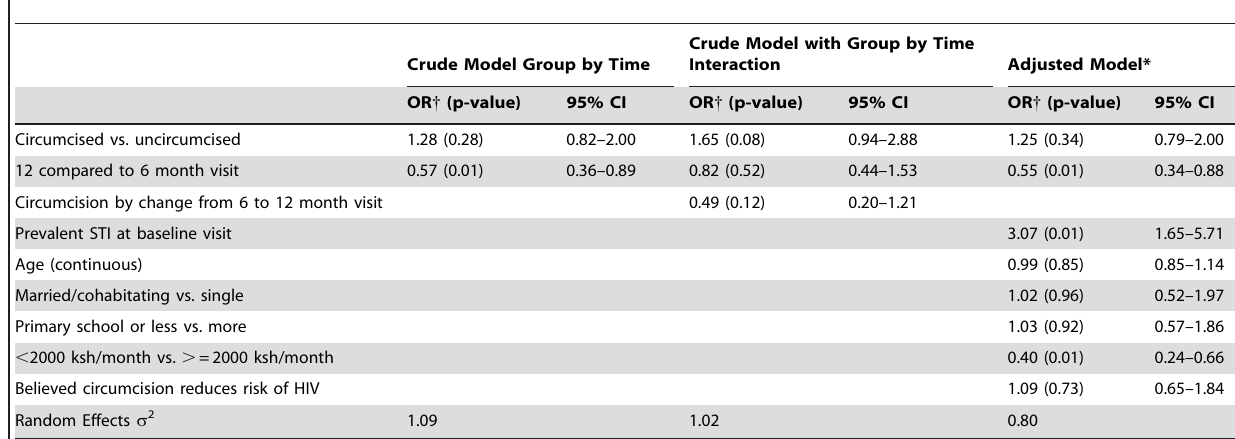
Table 4. Results of the Dichotomous Random Effects Regression Models for Incident Infections of Gonorrhea, Chlamydia, or Trichomoniasis, Circumcision Status, and Time With and Without Covariates